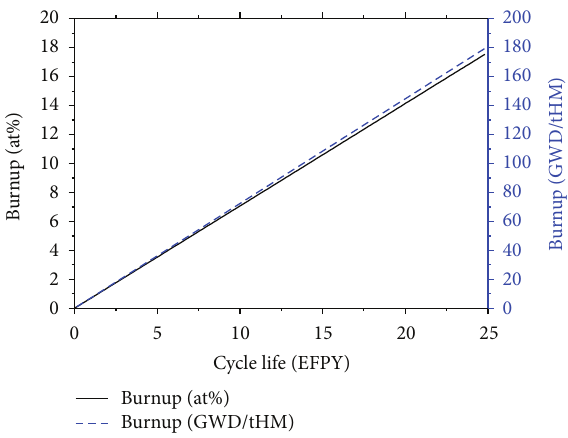
Figure 12: Burnup versus cycle length for reference core.